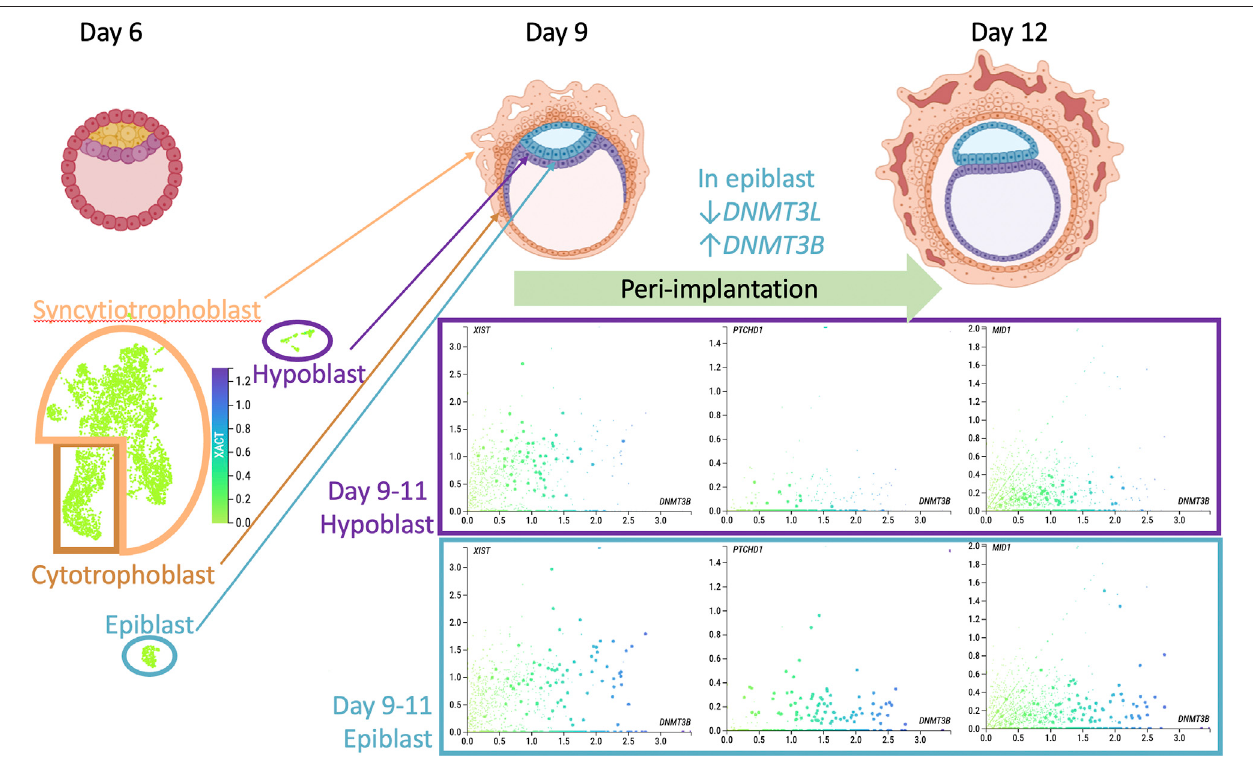
FIGURE 1 | Could X chromosome erosion occur in vivo ? Top row shows drawings of pre- (day 6 post fertilization) and peri-implantation human embryos with the majorcelllineageslabelled (fromBioRender.com). Bottompanelpresentsdataacquired fromMoleetal.,2021datasetinwww.humanembryo.orgwhichincludessingle cellRNA-seqfrom16humanperi-implantationembryos,8atday9and8atday11.Whilesexofembryoswasnotdeterminedinthepublishedstudy,anegligiblelevelof SRY expression was observed, consistent with female sex. UMAP image on left bottom shows XACT expression at low uniform level across all cells and lineages. Scatterplots from cells from only the hypoblast (top) or epiblast (bottom) colored for level of DNMT3B , a marker of epiblast post-implantation differentiation ( x -axis) comparedto y -axistranscriptlevels: XIST , PTCHD1 , MID1 (twoASDrelevantgenesfrom Table1 ).ScatterplotsshowthecomplexityofcellularvariationintheseX-linked transcripts, consistent with an extended period of XCI establishment and imprecise dosage compensation at the peri-implantation stage of human